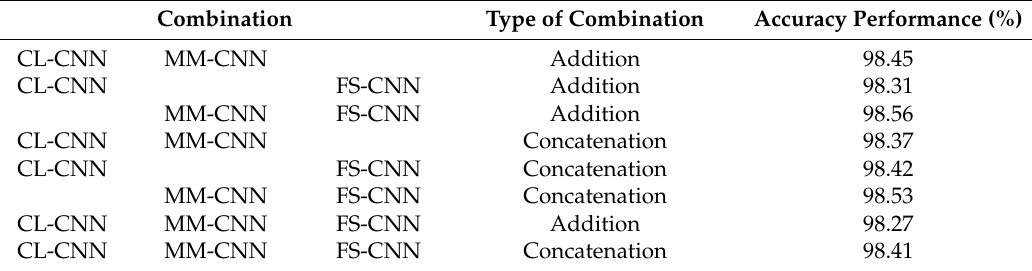
Table 5. Performance of Combining Features Generated by the FC layer.